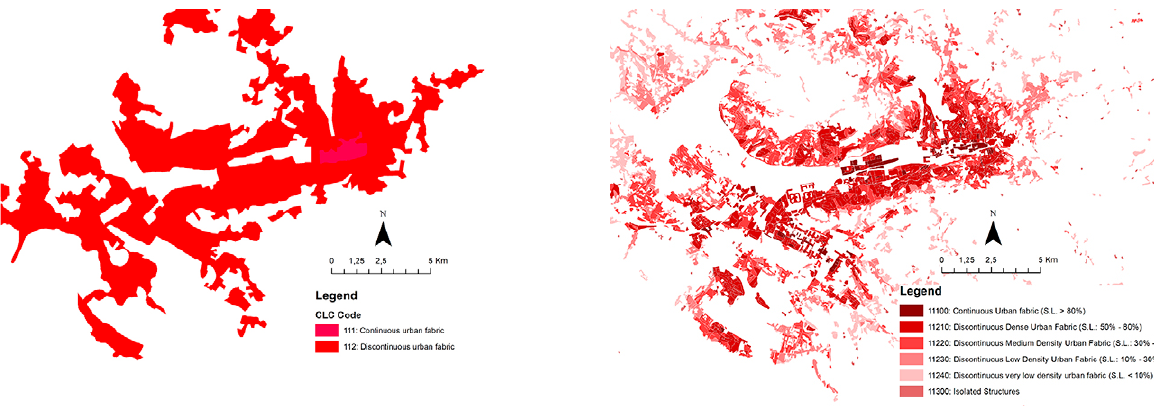
Figure 2 and 3. The difference between details level of CLC and UA dataset in Sarajevo urban area [click on figure to